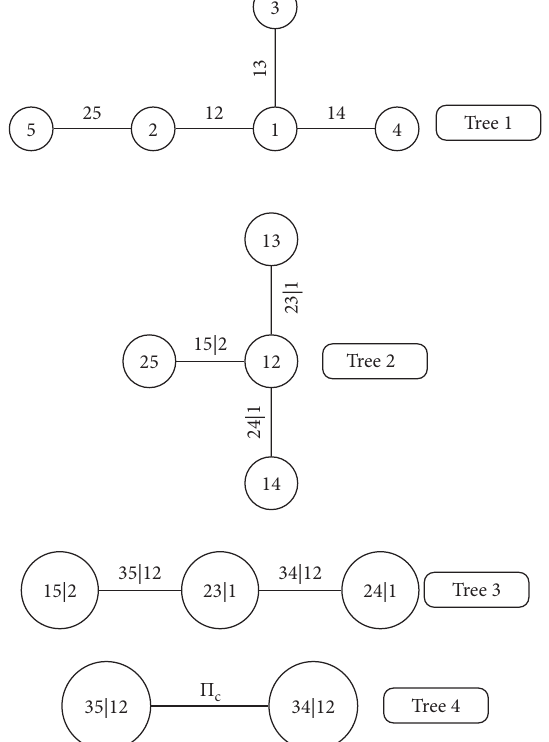
Figure 4: 3-levels truncated R -vine copula mixture model. 5-dimensional, 4 trees, 9 edges (nonindependent mixture of bivariate copulas and one edge (independent bivariate copulas)), and 27